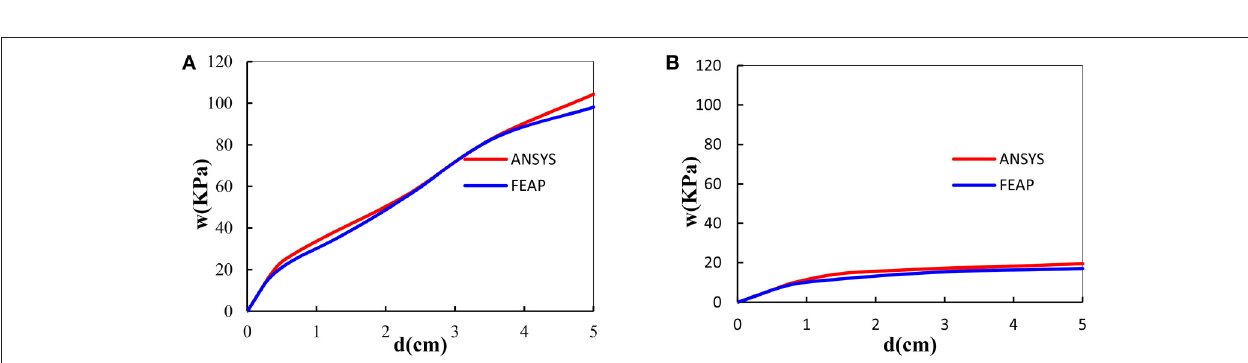
from the edges to the center and crushing occurs at the center on the top surface, while at the bottom surface, cracking grows from the central zone to the edges. On the other hand, in the simply supported circular slabs, cracking